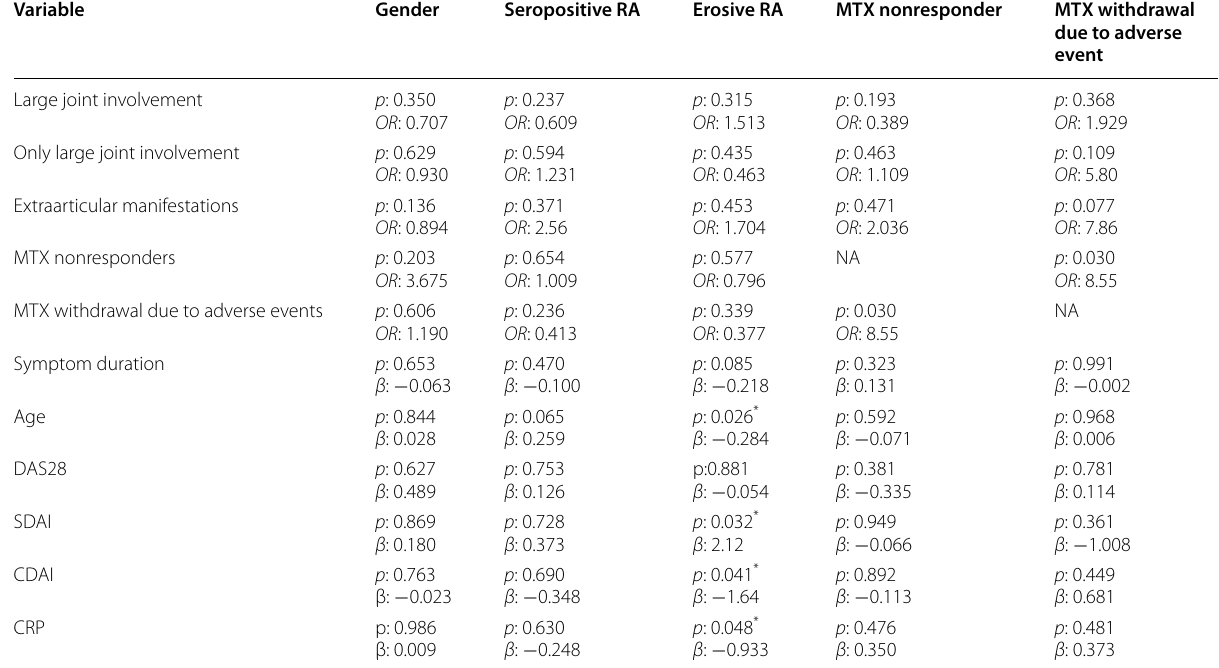
Table 1 Multiple linear and logistic regression analysis of LORA